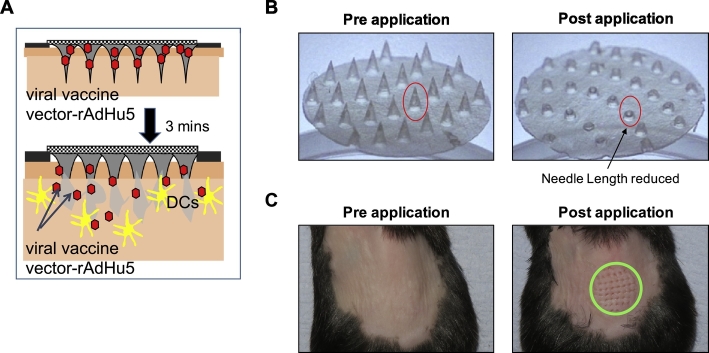
Microneedle Array (MA) mediated skin delivery. (A) Schematic representation of the mechanism of action of the dissolving MA. (B) MA fabricated with rAdHu5-CN54gag in a sucrose-Na-CMC matrix pre-(left) and post-(right) application. (C) En face view of B6 back skin (left) before and (right) 3 min after MA application.